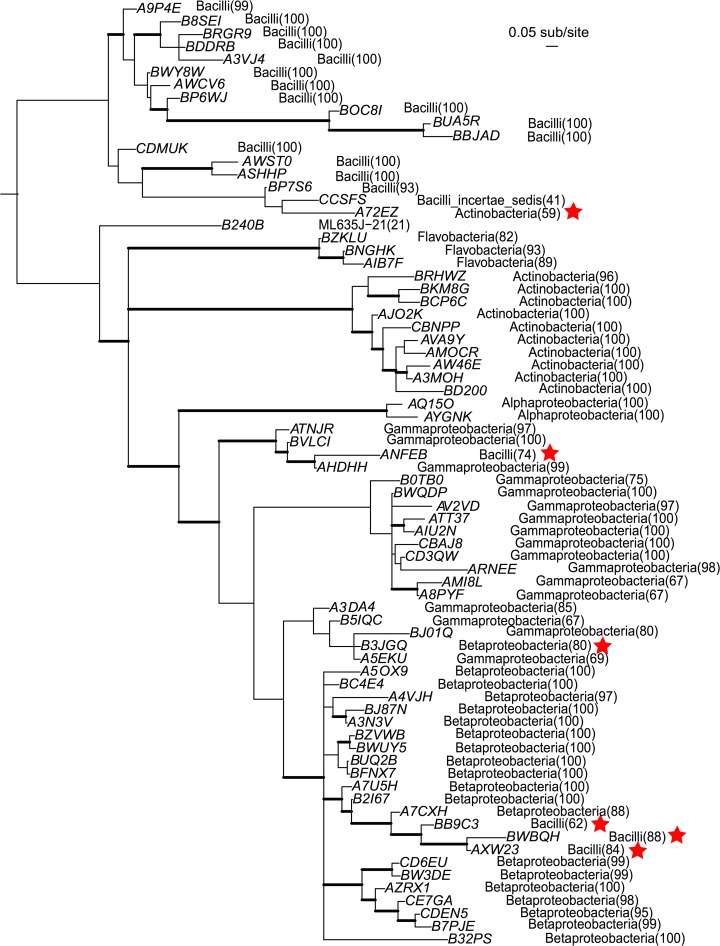
Consensus Bayesian inference tree showing phylogenetic relationships of representative sequences of 74 bacterial OTUs, and their classifications at the level of Class (classification bootstrap confidence in parenthesis).The IDs of the OTUs are abbreviated by only keeping their unique, last five characters (e.g., HUSOE0I01A9P4E to A9P4E). The tree was inferred by combining these sequences with 274 16S rRNA sequences from [42], followed by dropping the latter sequences from the tree using the drop.tip function found in the R package “ape”. Thickened branches indicate posterior probabilities of 90% or higher; stars signify sequences that have classification-phylogeny incompatibility. See S1 Fig. for classifications of the OTUs at various taxonomic levels. See S2 Fig. for the full trees that include sequences from [42].